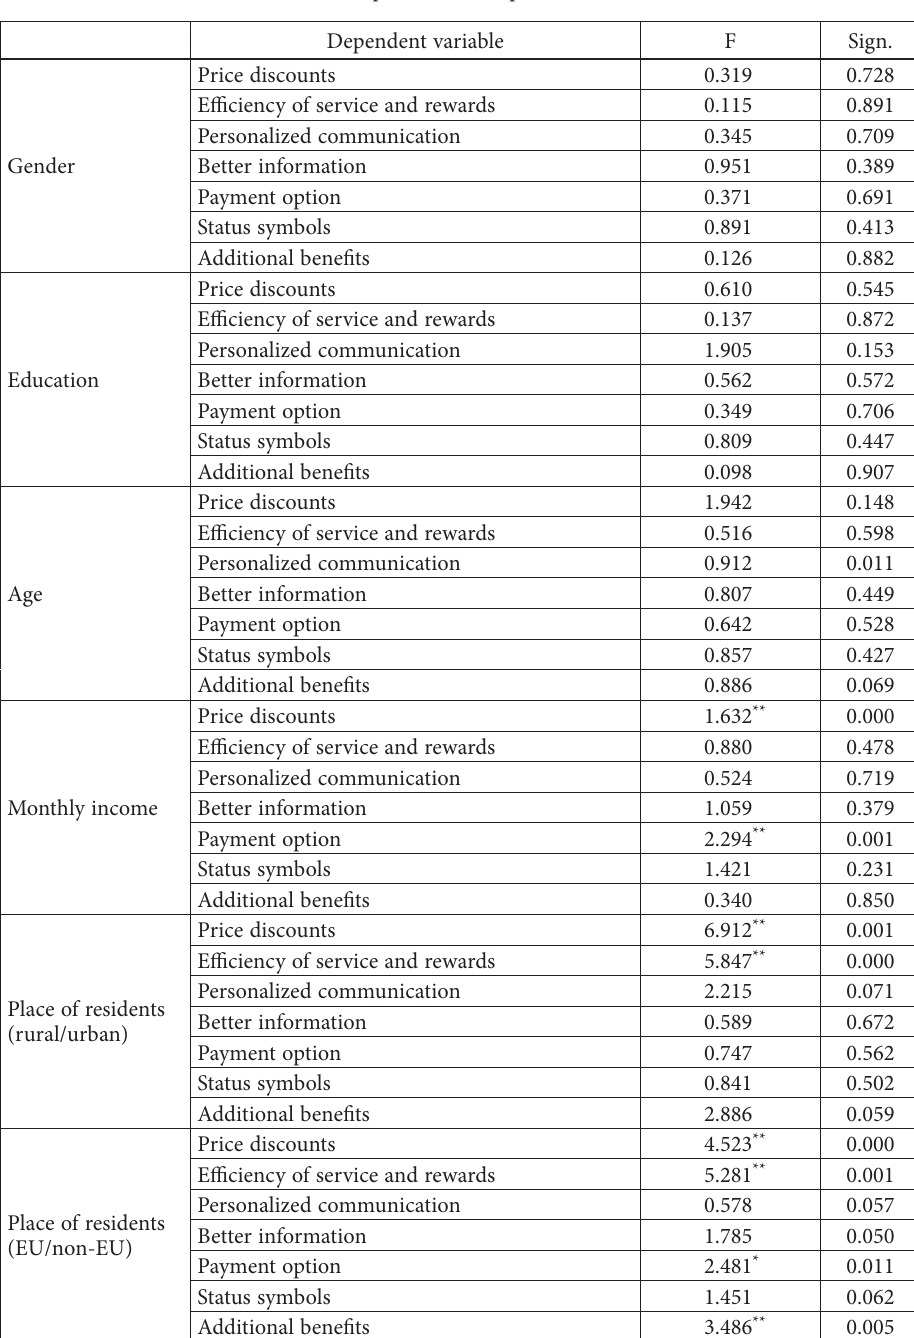
Table 5. Predictor contributions to the explanation of dependent variables Dependent variable